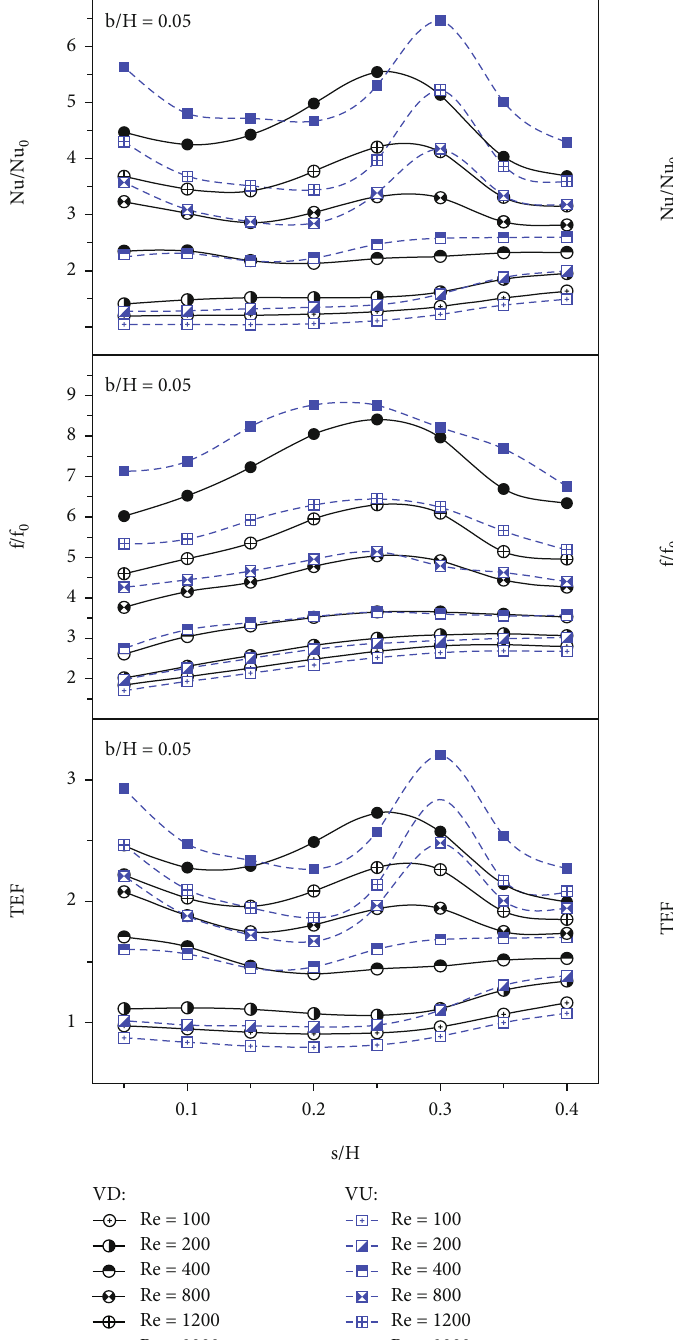
Figure 9: Thermal performance analysis of b / H = 0 : 05 . Figure